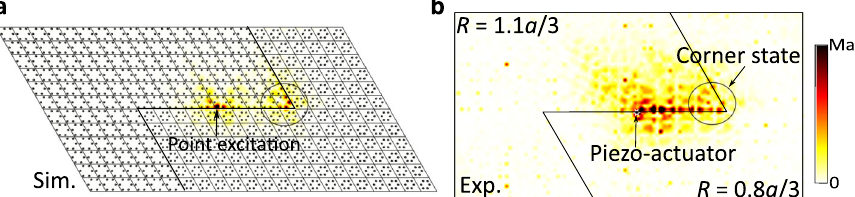
Fig. 5 Demonstration of asymmetric wave localization when the source excites the middle of the Z-shaped interface. a Simulated wave fi eld with harmonic excitation at f = 8.49 kHz showing the excitation of the corner state on the right. b Experimentally-extracted wave fi eld captures the excitation of the corner mode marked within the